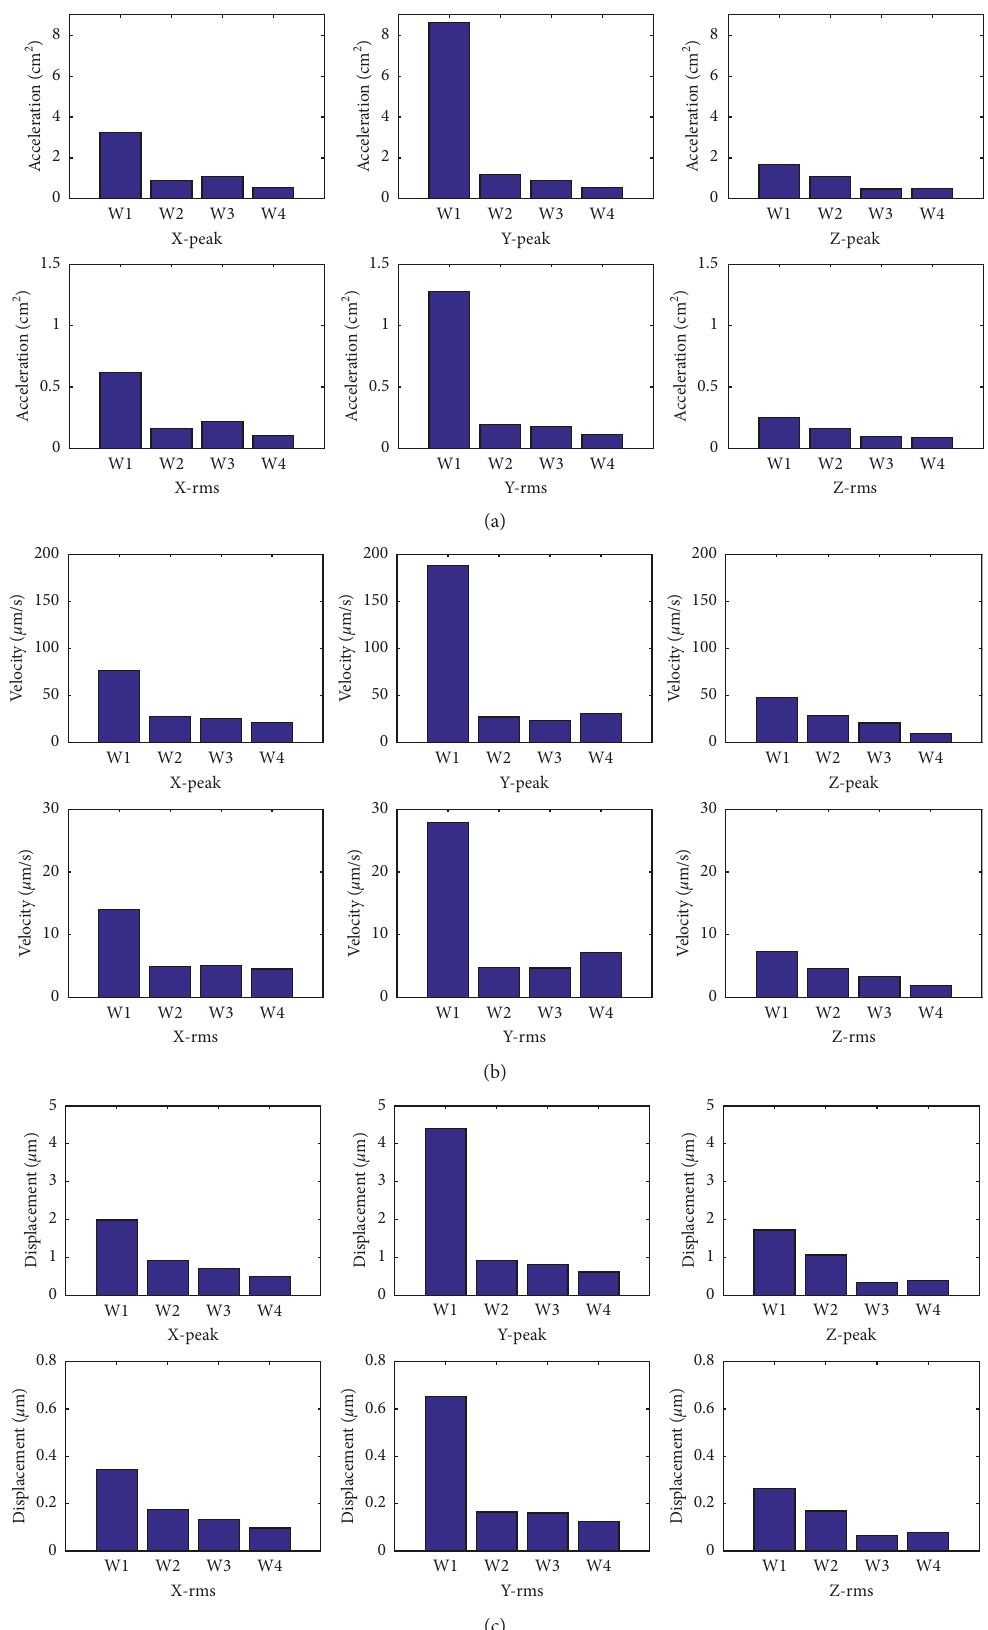
Figure 8: The average value of 3 indexes induced by subways on free field. (a) Acceleration. (b) Velocity. (c)